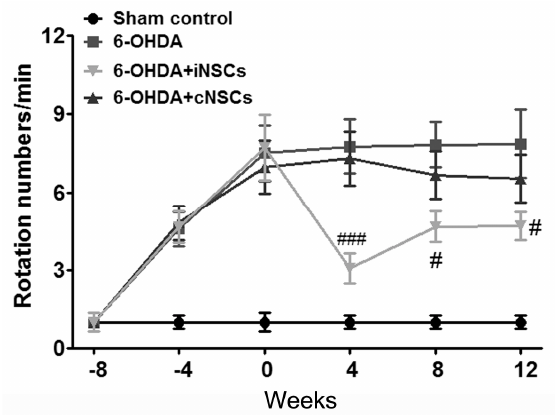
Figure 6. Engrafted iNSCs improved motor performance in the 6-OHDA-induced PD mouse model (a) Total apomorphine-induced rotation numbers (0.5 mg/kg) were counted at 4, 8, and 12 weeks after cell injection. iNSCs ( n = 12) injected group showed the improved symptom compared to PBS injected groups ( n = 12), while average rotation score of the iNSC group was decreased compared to the cNSC injected group. Each value depicts mean ± SEM of number of rotation. # p < 0.05, ### p < 0.001 vs. 6-OHDA.